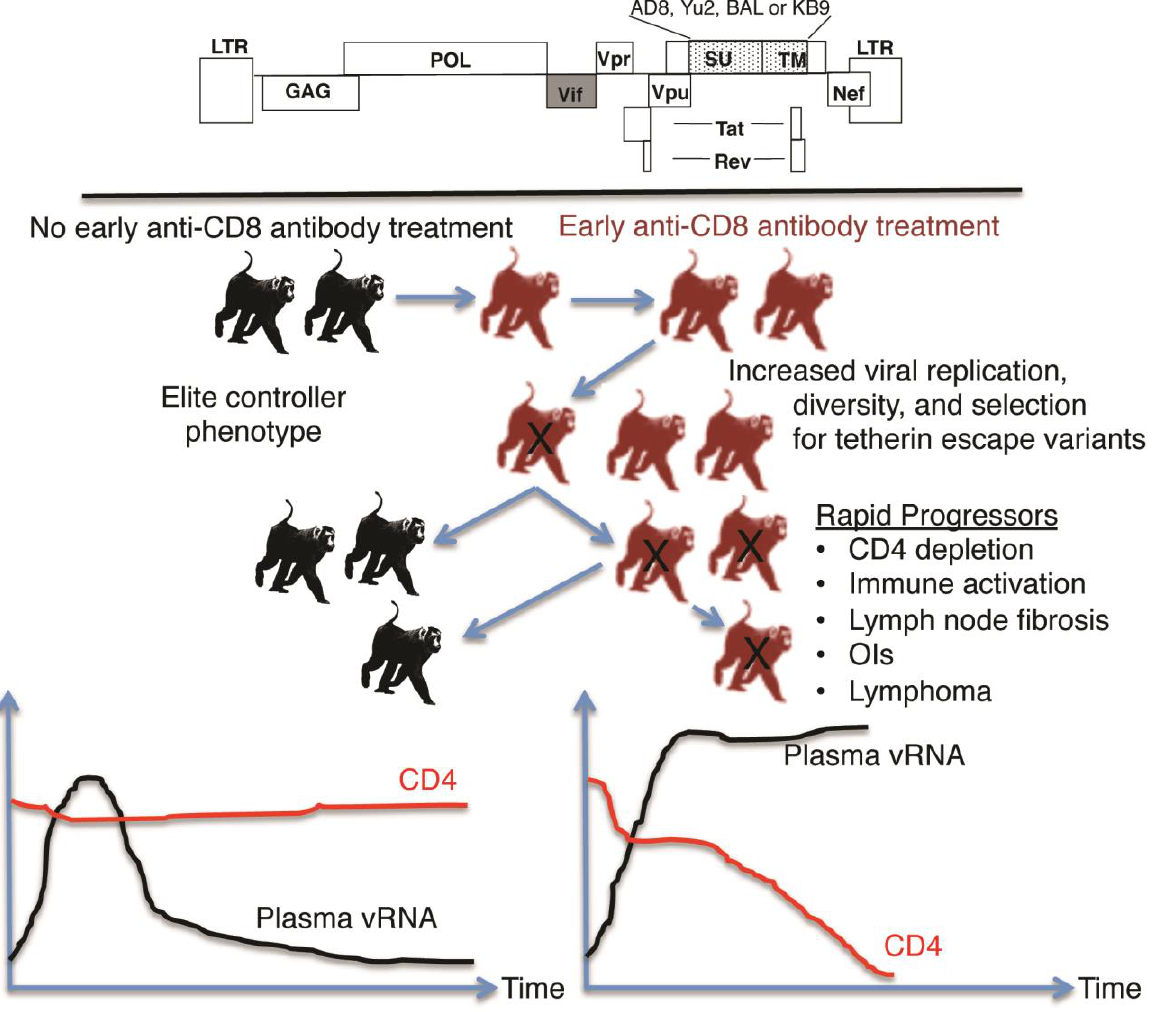
Figure 1. Selection of pathogenic macaque-tropic HIV-1. Pig-tailed macaques were inoculated with a mixture of macaque-tropic HIV-1 clones that contained the env genes of four different CCR5-tropic viruses in a NL4-3 backbone with a SIVmac239 vif replacement. Viruses were inoculated and passaged through pigtails that received anti-CD8 antibody treatment (red) or no treatment (black). Early CD8 cell depletion increased viral replication and emergence of pathogenic macaque-adapted HIV-1. Rapid disease progression (X) depended on CD8 depletion as pigtails that did not receive early anti-CD8 antibody treatment controlled the infecting